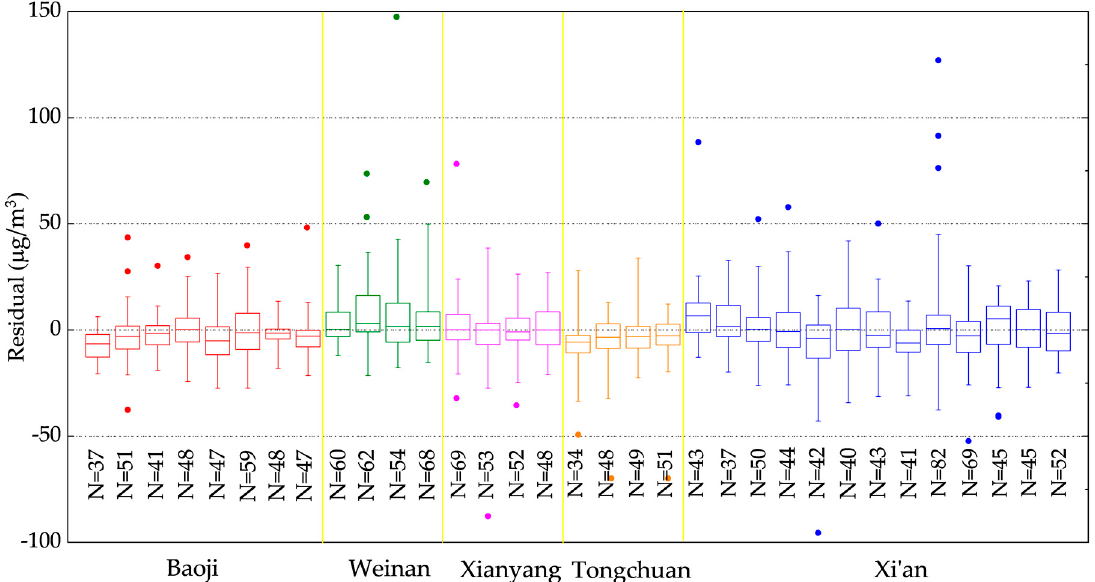
Figure 5. The PM 2.5 residuals ( µ g / m 3 ) at each monitoring site in the five cities: Baoji, Weinan, Xianyang, Tongchuan, and Xi’an. The solid line in every box is the median for each site. The top of the box is the upper quartile, while the bottom of the box is the lower quartile. The lines on the box are the maximum and minimum values, respectively. The colored circles are outliers of residuals for every site. N is the number of data points for each station.